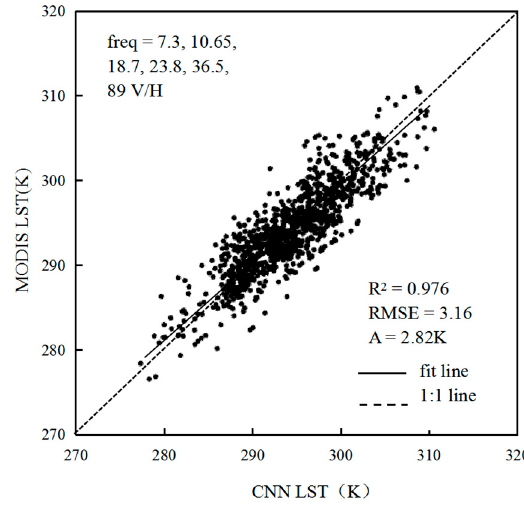
Figure 4. Scatterplot of CNN retrieval results and MODIS LST data. Table 2. Errors under different channel combinations.